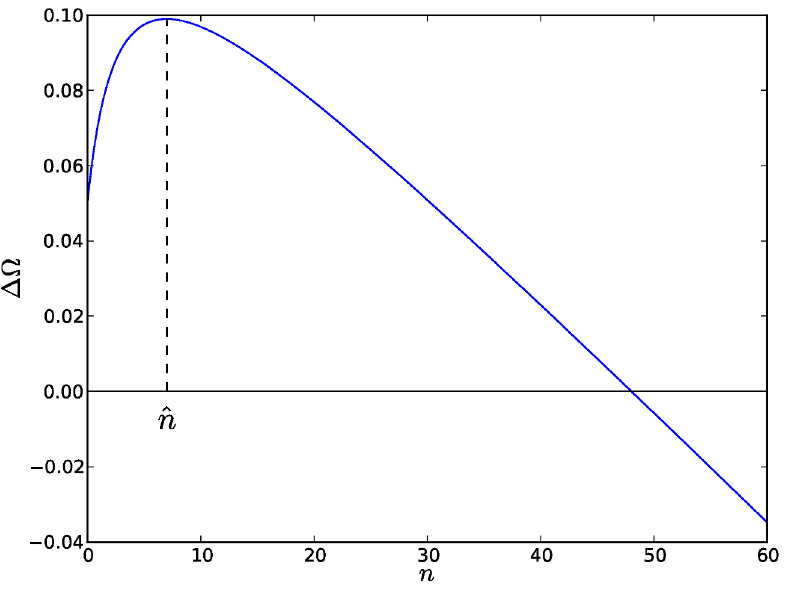
Figure 1. Effect of plasmid copy number on cellular growth. Cellular growth rate DV as a function of the plasmid copy number n (following Equation 1), with v 0 ~ 0 : 05 , w ~ 0 : 1 , c ~ 3 | 10 { 3 and l ~ 3 . The copy number ^ nn ~ 7 , which is optimal for cell growth, is denoted by the vertical dashed